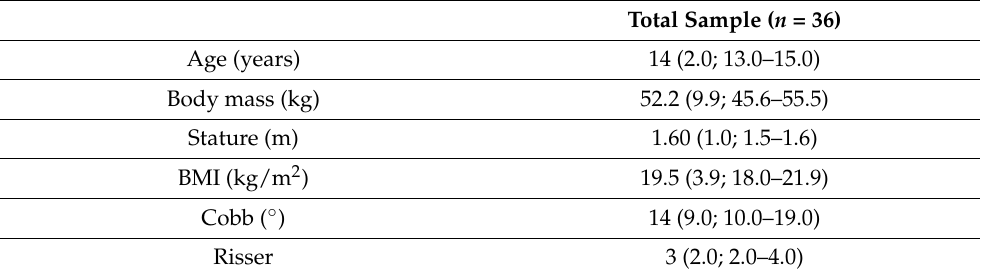
Table 1. Descriptive characteristics of the whole sample.